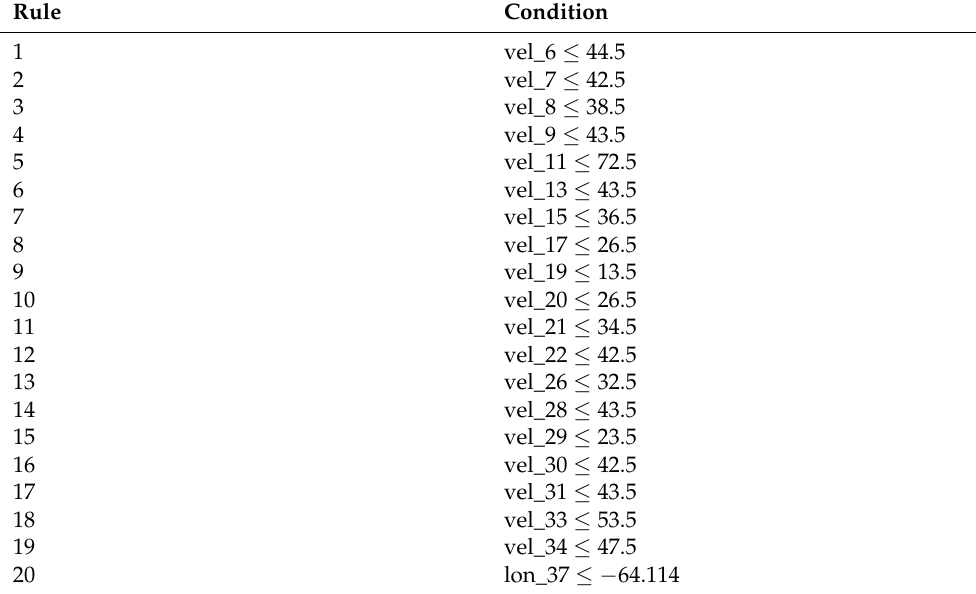
Table 14. Decision rule table for normal time